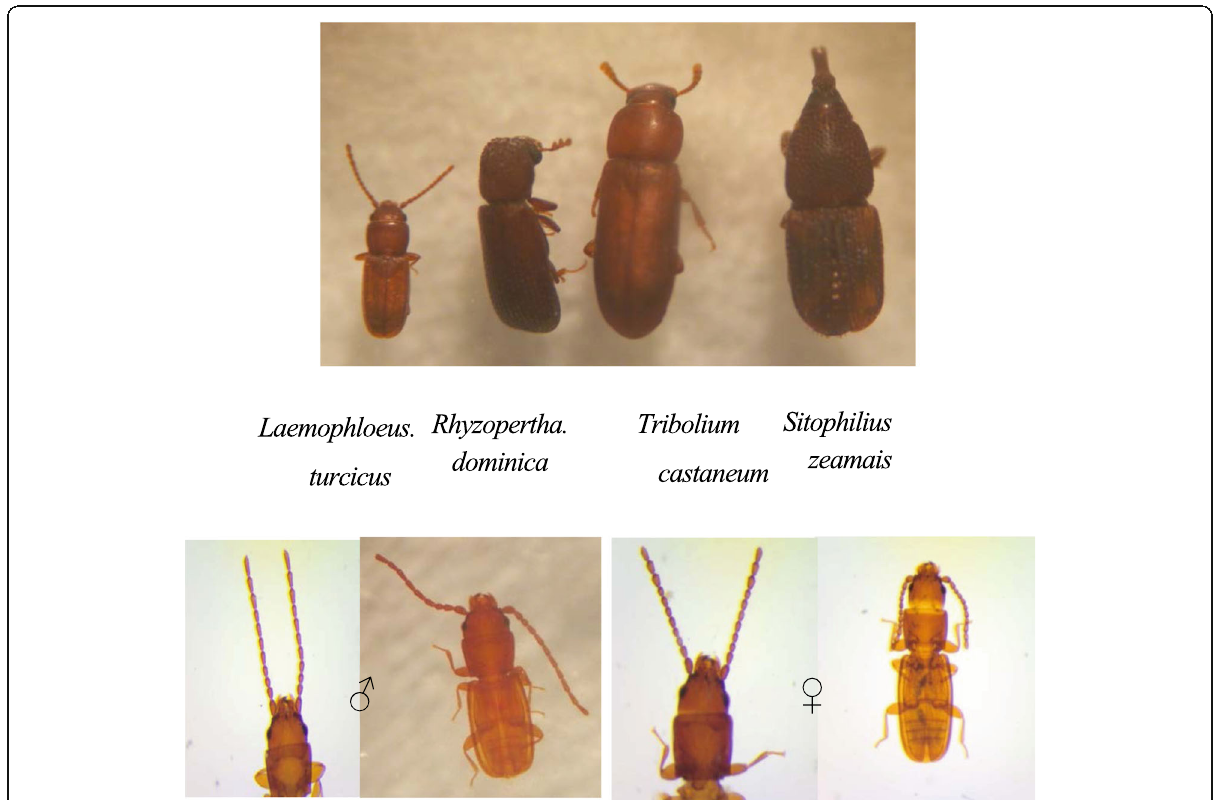
Fig. 1 The coleopterous pests associated with crushed-maize grain-laboratory cultures; (×25 magnification). Below, Laemophlaeus turcicus adult male (left, male sign; antennae: filiform) and female (right, female; antennae: moniliform), with anterior end magnified (×100 magnification)